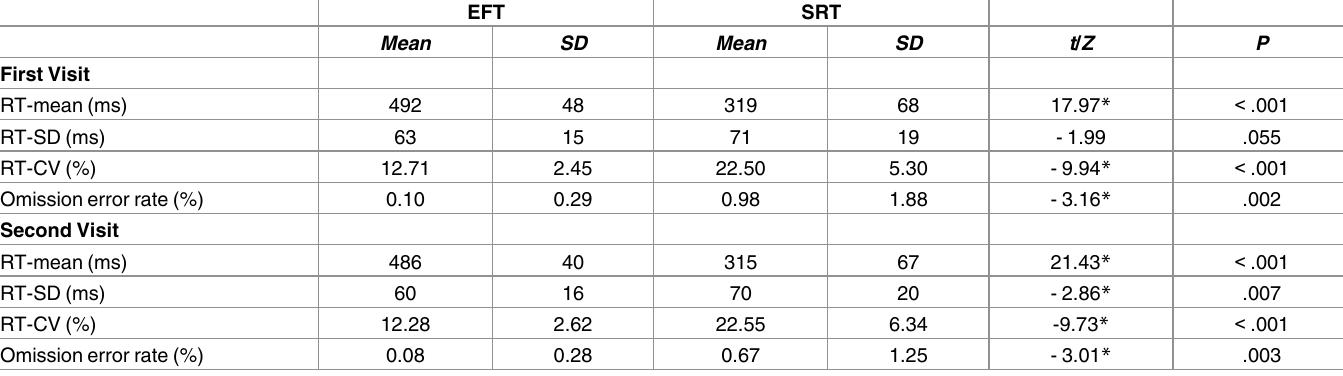
Table 4. Comparisons of conventional measurements made between tasks for each visit. A paired-t test ( t ) was performed on RT-mean, RT-SD and RT-CV values. A Wilcoxon signed rank test ( Z ) was performed on omissionerror rates.